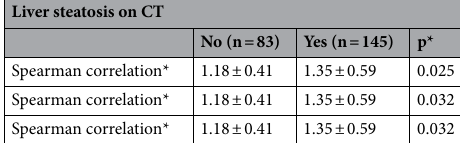
Table 3. Comparison of HS and PS for different CT scan technics. *Spearman correlation.